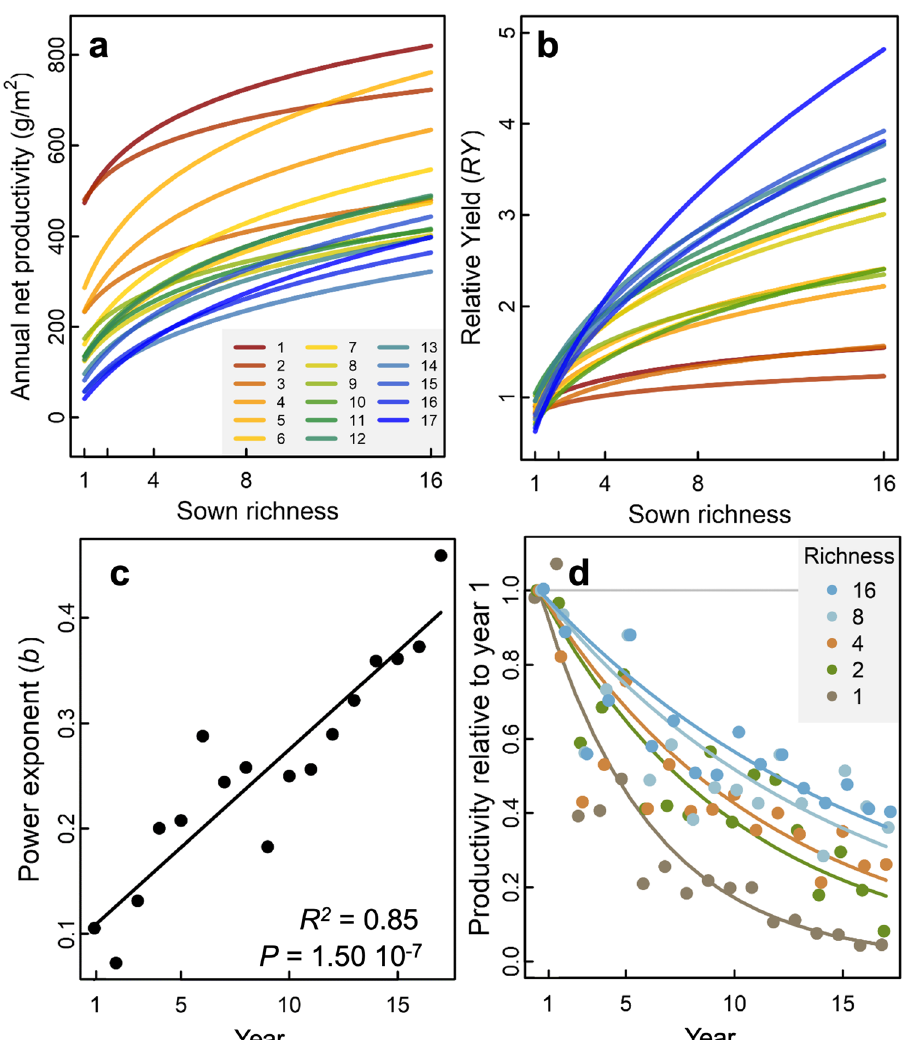
Fig.1|Sownspeciesrichness – productivityrelationshipsthroughtime. Thelog- linearrelationshipsbetweensownspeciesrichnessand a abovegroundnetprimary productivity (ANPP square root transformed prior to analysis) of the communities and b relative yield (ANPP divided by mean ANPP of monocultures in that year) of the communities are shown for each year (1=2003, 17=2019). c The slope of the